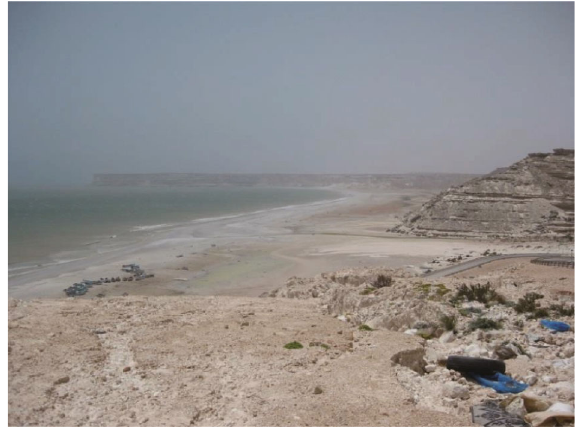
Figure 4: View of the crenulated bay from the northern headland (Ras Markaz is in the background).